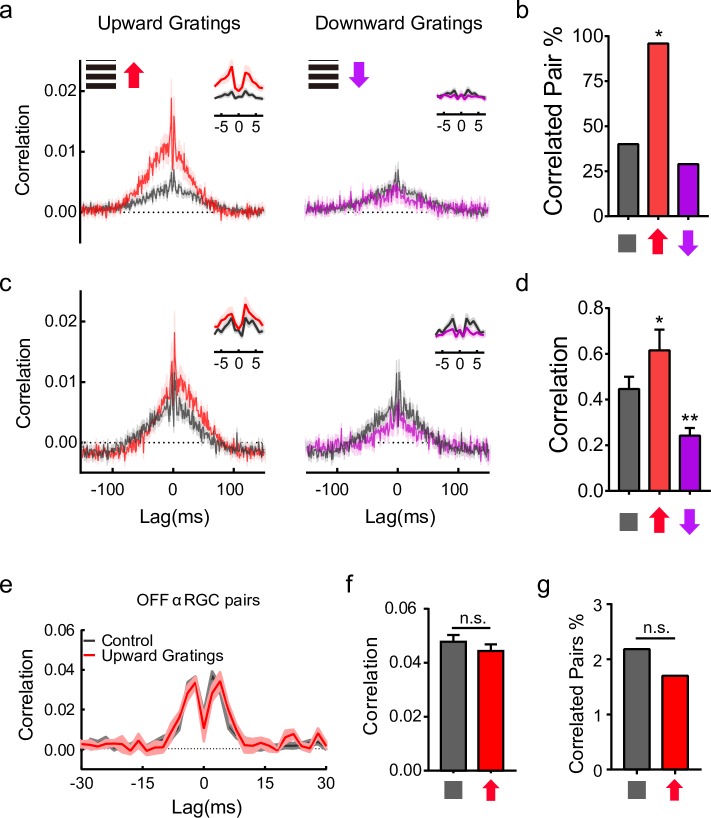
Proportion of correlated pairs and correlation strength are both affected by VME.(a) Average cross-correlogram of V-DSGC pairs at a close distance. Cross-correlograms of all V-DSGC pairs within 250 μm of each other are averaged. Control, gray, n = 75; upward VME, red, n = 24; downward VME, magenta, n = 38; shaded areas, ±SEM. Insets are close-up views with 1-ms bin size. (b) Proportion of V-DSGC pairs with measurable activity correlation in different groups shown in (a), with the same color codes. Control/upward VME/downward VME: n = 75/24/38 pairs. The proportion of correlated pairs show significant difference between the control group and the upward VME group. Chi-squared test, p = 0.01 for upward VME group, p = 0.48 for downward VME group. (c) The same as in (a), except that, of the V-DSGC pairs represented in (a), only those with significant spike time correlation are used for averaging. Control, gray, n = 30; upward VME, red, n = 23; downward VME, magenta, n = 16; Shaded areas, ±SEM. (d) Quantification of correlation strength from cross-correlograms in (c), computed as described in 2d. **p < 0.01, *p < 0.05, unpaired t test. Error bars, SEM. (e, f, g) Comparison of the gap junction connections between OFF αRGC pairs. (e) Average cross-correlograms of all correlated OFF αRGC pairs. (f) Quantification of total correlation strength based on (e). The sum of the spike time cross-correlation in (e) from −15 ms to +15 ms is used for comparison. No significant change in the strength of correlation can be detected, p = 0.52, unpaired t test. (g) Proportion of correlated OFFα RGC pairs show no difference between control and upward VME. Chi-squared test, p = 0.53. Control, gray, n = 45 pairs; upward gratings VME, red, n = 11 pairs. Shaded areas, ±SEM. Data for this figure are in S4 Data. αRGC, alpha retinal ganglion cell; V-DSGC, ventral-preferring direction selective ganglion cell; VME, visual motion experience.